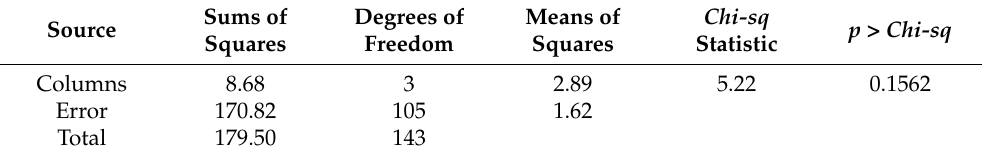
Table 14. Results of Friedman test for oil Midel 1204 with different concentrations of surfactant oleic acid.